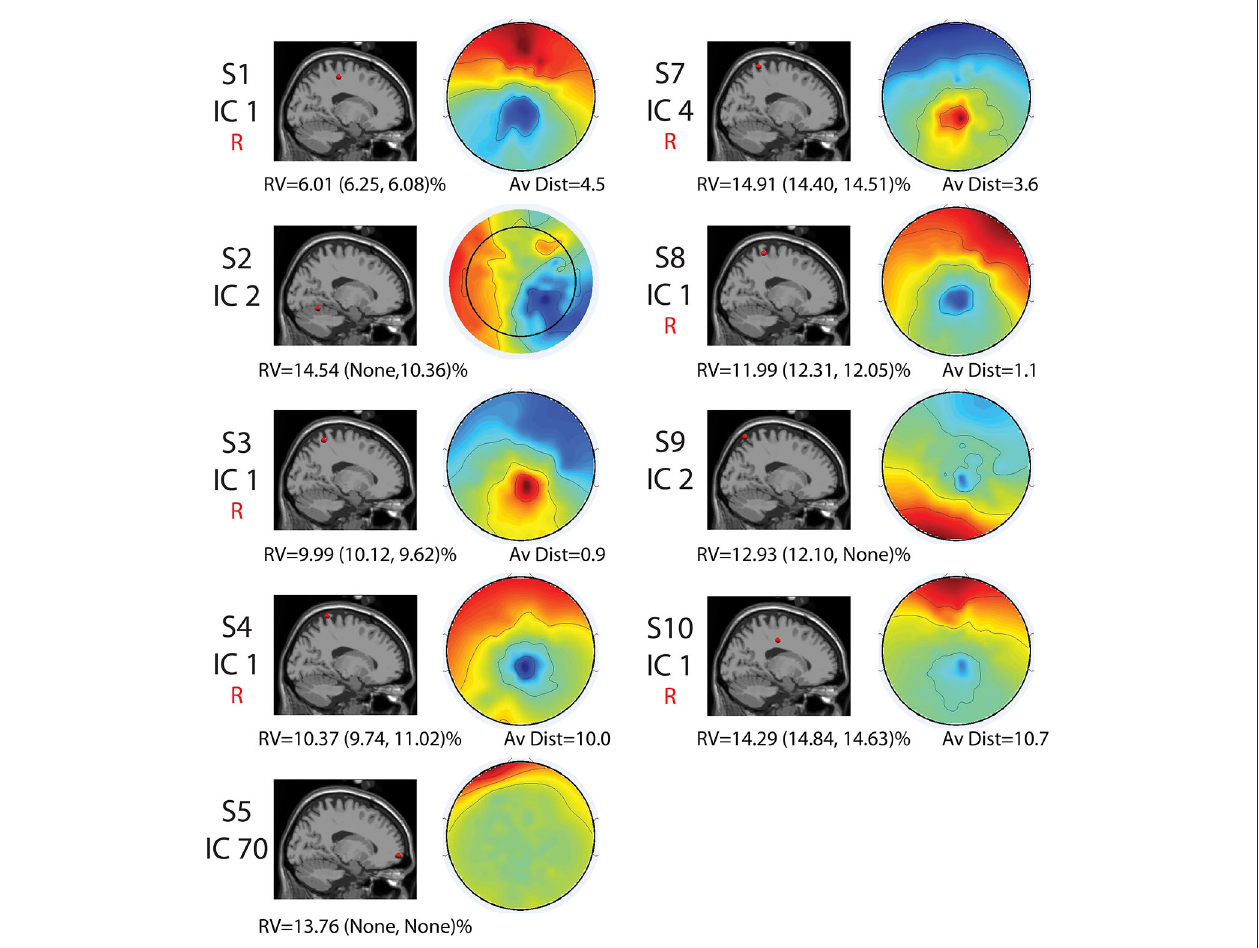
FIGURE 3 | Cortical component characteristics. Cortical locations, topographic maps, residual variance (RV) values for the full set and for each half set for the split-half comparisons (in parentheses), and average distance between analogous components for the full-set and each half set in Talairach coordinates are shown for the nine components with RV < 15% and neural locations for the full set. The word “None” appears when there were no components with neural locations and RVs < 15% for a given set. Components that were reliably identified for all three sets are labeled with a red “R.” Alone, these characteristics are not enough to declare all of these components